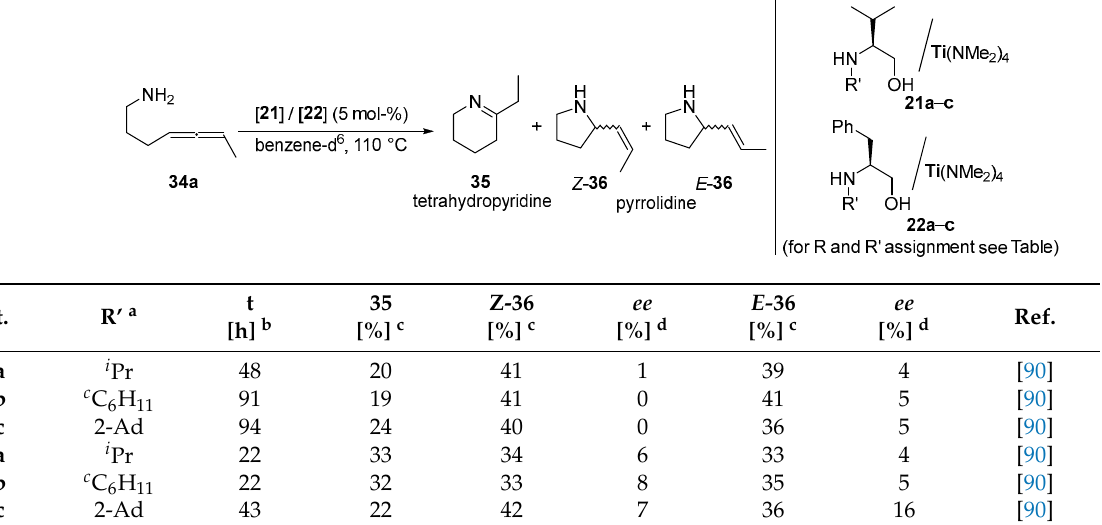
Table 5. Catalytic asymmetric hydroamination of 34a using chiral rare earth metal complexes 21a – c and 22a – c .